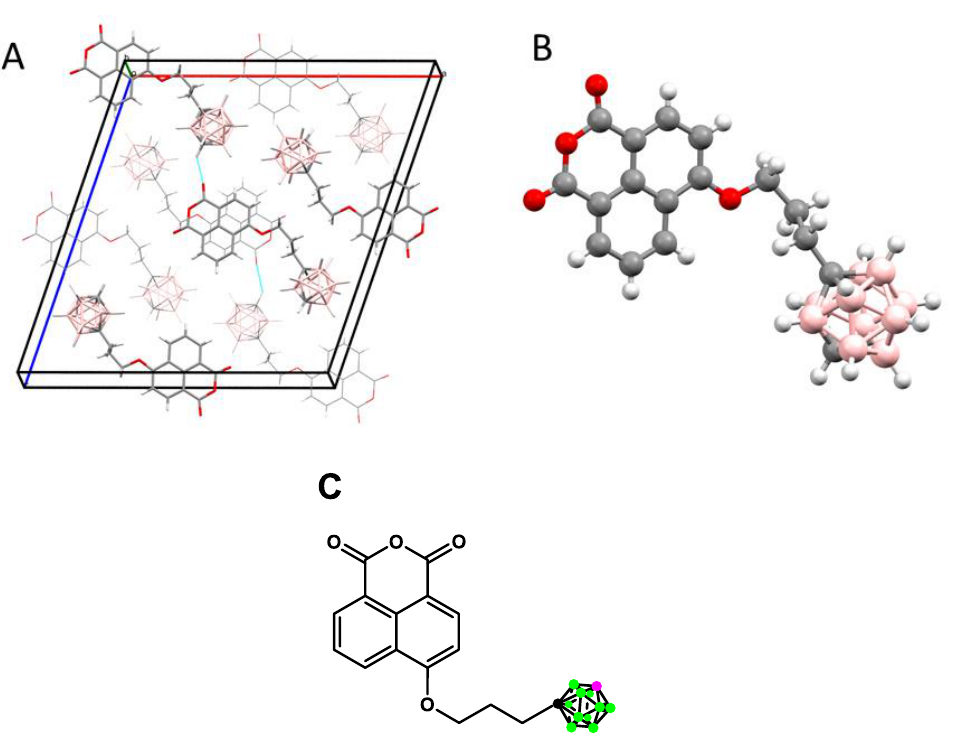
Figure 2. The crystallographic structures of 23 : ( A ) crystal packing within the unit cell and ( B ) the molecular structure. Hydrogen bonds are marked between the CH groups of the carborane clusters and the carbonyl oxygen atoms of the neighboring molecules (blue lines); ( C ) chemical structure of compound 23 .